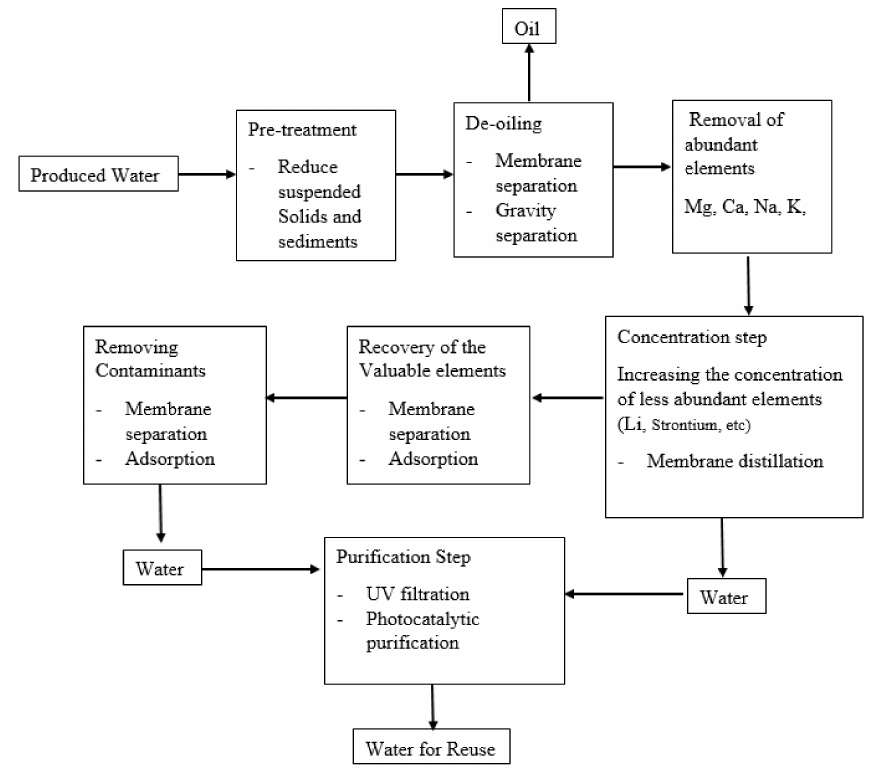
Figure 2. Schematic of a process train for the separation and recovery of high-value